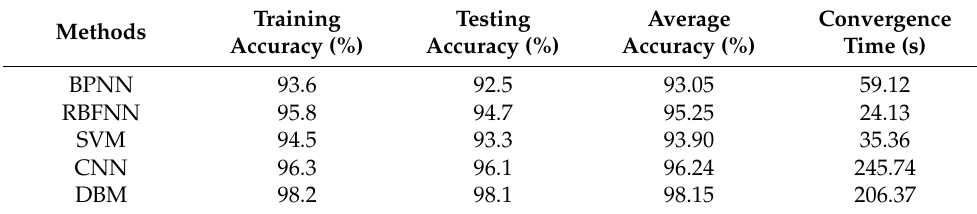
Table 3. Comparison of